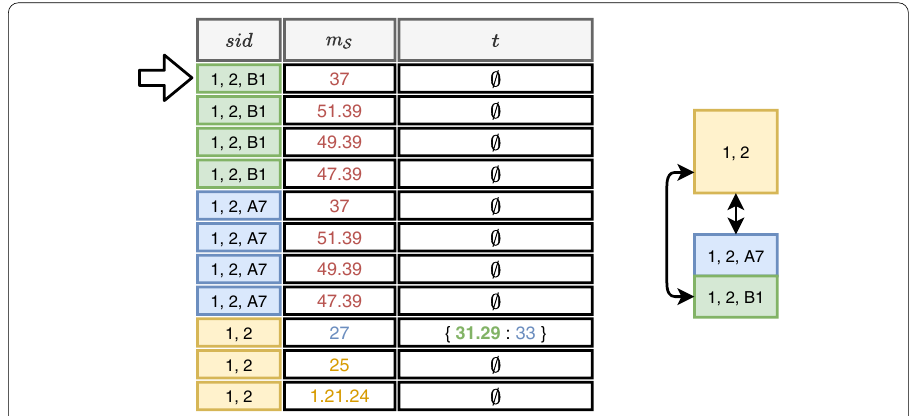
Fig. 11 Stack M and instance category I when the first iteration of tree processing